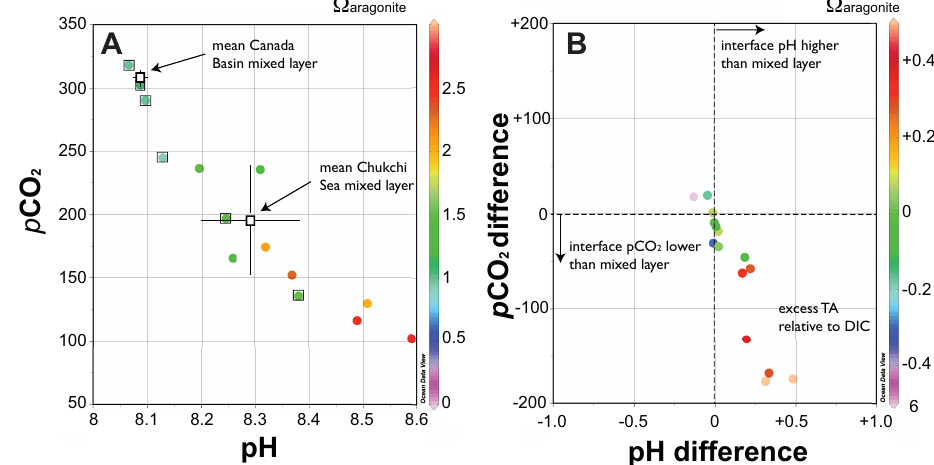
Figure 11. Scatter plots of interface melt water CO 2 –carbonate chemistry from the 2010 and 2011 ICESCAPE cruises in the western Arctic Ocean. Panel (a) denotes pH against p CO 2 (µatm) with range of colour denoting (cid:127) aragonite values. The Canada Basin samples are denoted by symbols surrounded by square symbol. Panel (b) denotes the differences in pH against p CO 2 (µatm) and (cid:127) aragonite values relative to the underlying mixed layer at each ice